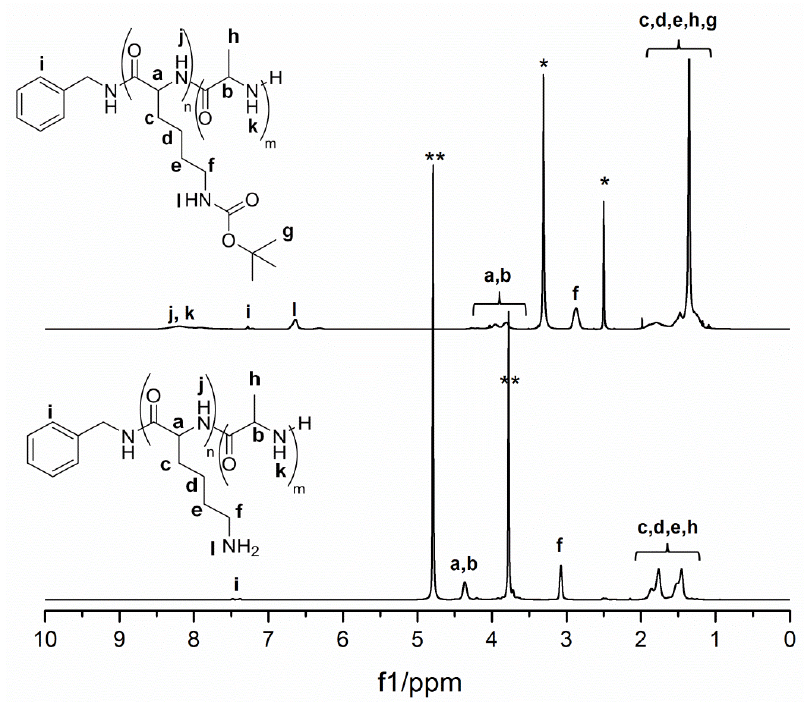
Figure 1. 1 H NMR spectra of K 46 A 33 before (top) and after (bottom) deprotection of the lysine residues. Asterisk (*) indicates residual solvent peaks from d 6 -DMSO (d 5 -DMSO and HDO), double asterisks (**) indicate residual solvent peak from D 2 O (HOD) and triple asterisks (***) indicate trace impurities from diethyl ether